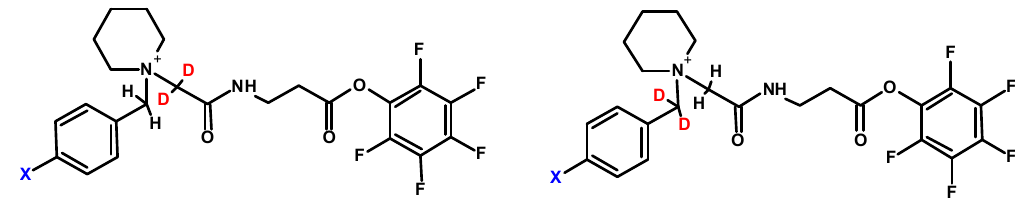
Figure 11. The structures of QAS-iTRAQ 2-plex (X = Br, I) [9].